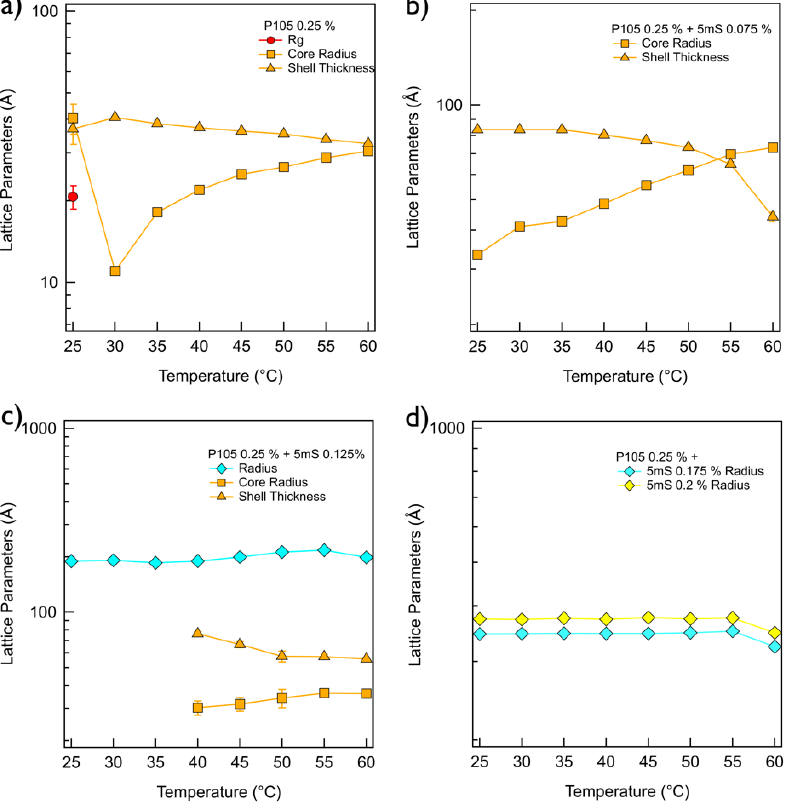
Figure 5. Fitting parameters obtained from the SANS analyses of P105 (0.25%)-5mS ( a ) 0 wt%, ( b ) 0.075 wt%, ( c ) 0.125 wt%, ( d ) 0.175 wt%, and ( e ) 0.2 wt% mixtures.